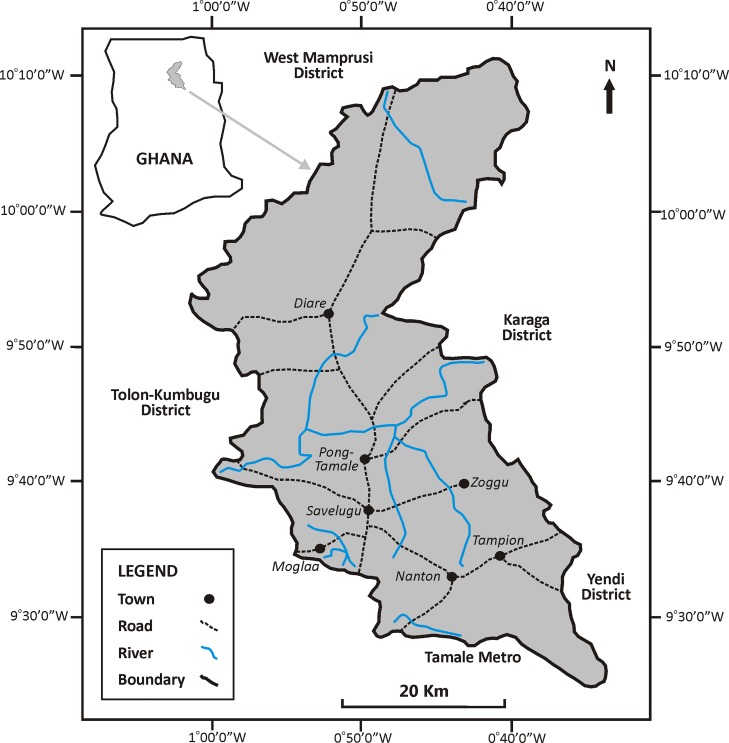
Map of the Savelugu-Nanton District in northern Ghana, showing major roads, rivers, and the seven selected townships for the study.Line drawings produced with CorelDraw version 13.